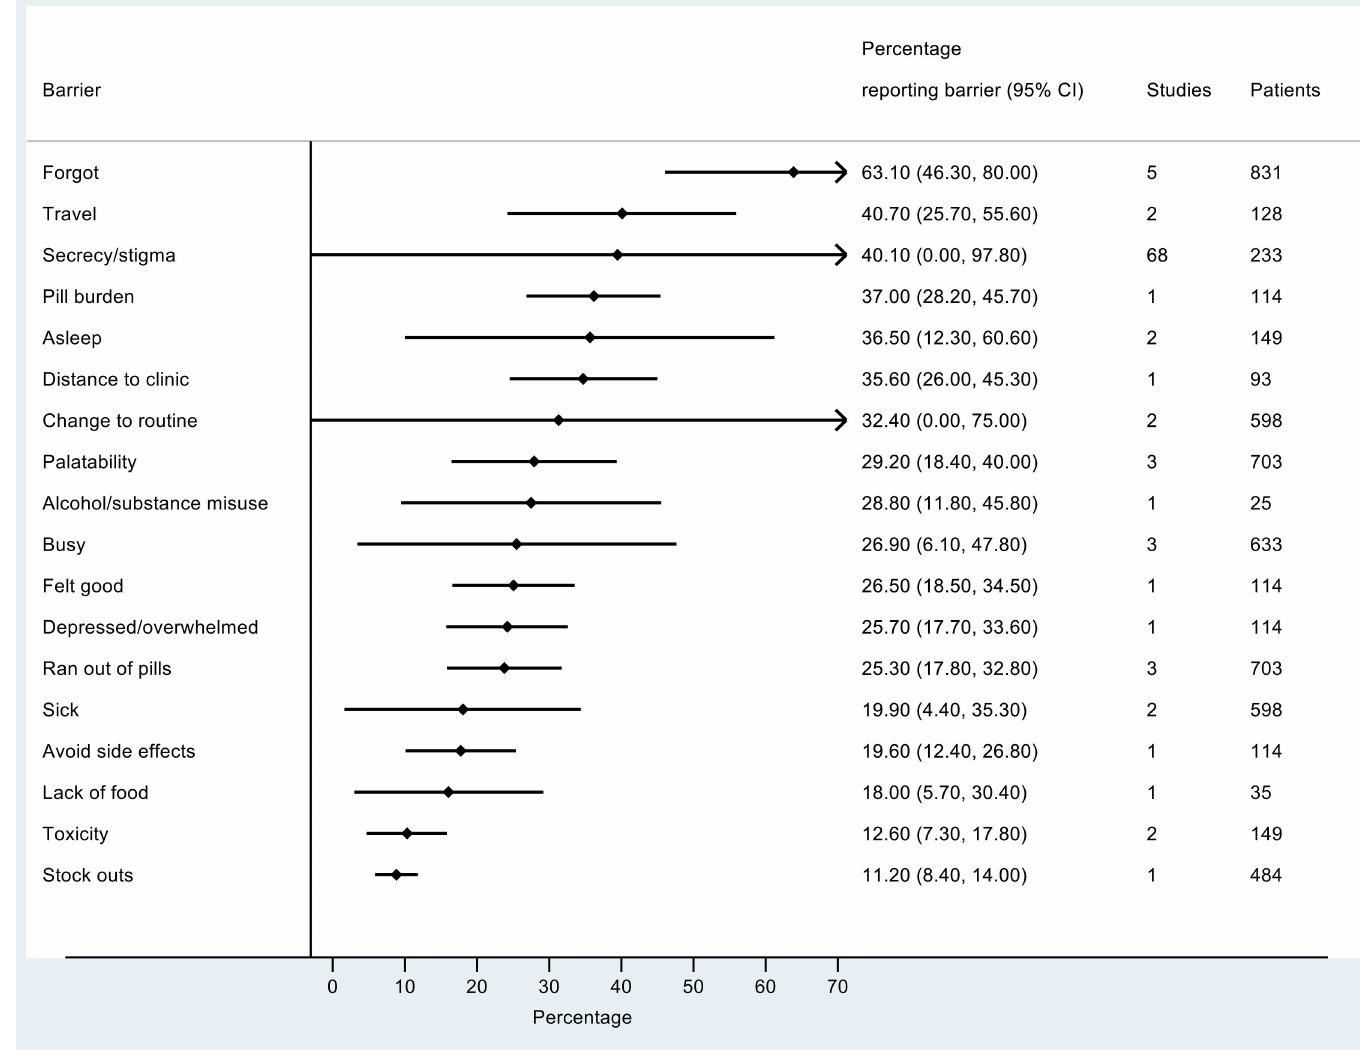
Fig 4. Barriersto adherence among adolescents on ART.